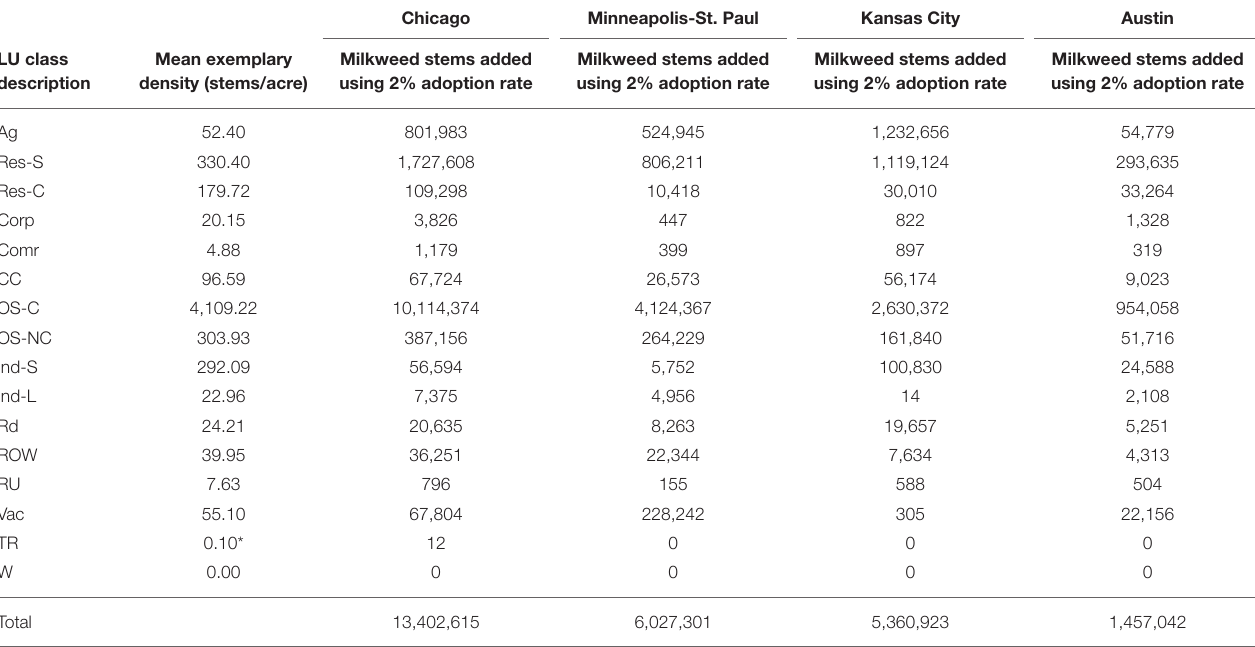
TABLE 3 | Baseline milkweed densities (stems/acre) used as input for the Urban Milkweed Baseline Tool for each metropolitan area and the resulting outputs including acres of plantable space and estimated count of current milkweed stems.